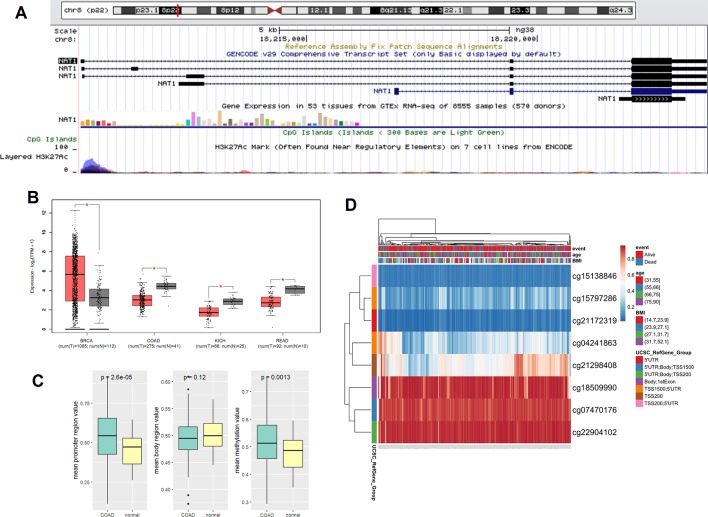
(A) Genomic position and functional annotation of N-acetyltransferase 1 (NAT1) gene from the University of California Santa Cruz genome browser; (B) Comparison of NAT1 mRNA in cancers and corresponding normal tissues; (C) The mean methylation of NAT1 in promoter region of COAD and normal tissues; (D) Heatmap of methylation CpG sites of NAT1 in COAD. *p < 0.05.